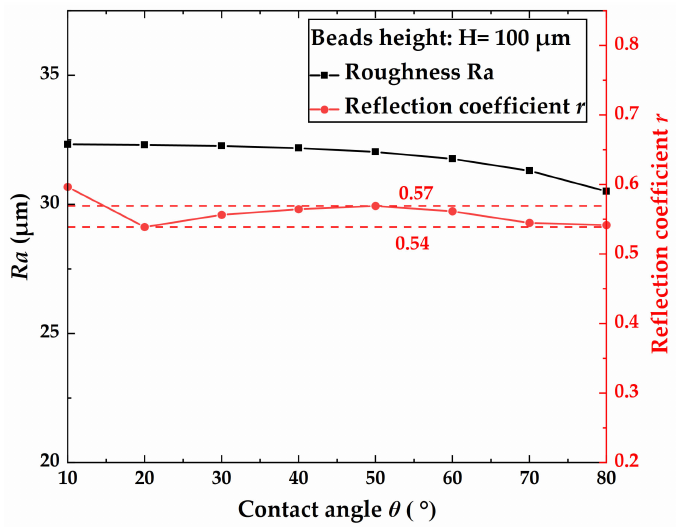
Figure 12. Numerical simulation results of roughness Ra and reflection coefficient r vs. contact angle.